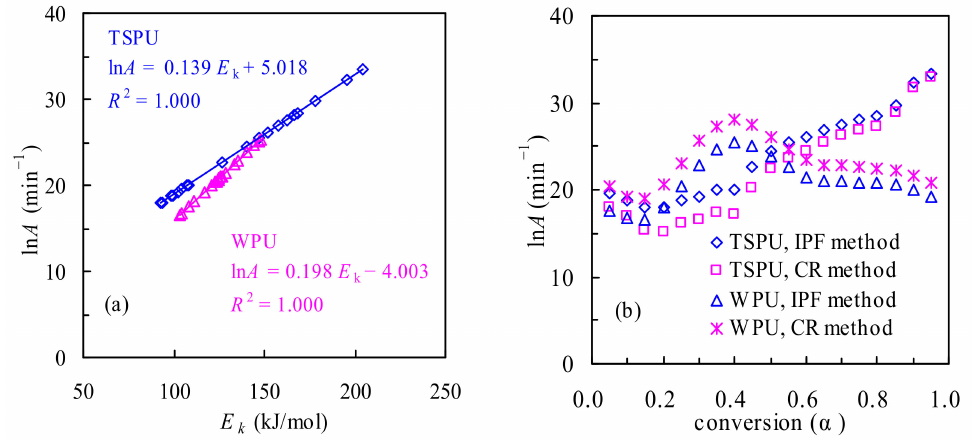
Figure 5. Compensation effect ( a ) and lnA~ α relationship ( b ) for TSPU and WPU. As can be seen from Table S6, the lnA from the IPF method for the TSPU waste ranges from 17.94 to 33.42, or the A value spans from 6.18 × 10 7 to 3.26 × 10 14 min − 1 , correspondently. In the case of the WPU waste, the lnA value is seen to vary from 16.56 to 25.41 or the A value ranges from 1.56 × 10 7 to 1.07 × 10 11 min − 1 , heavily dependent on